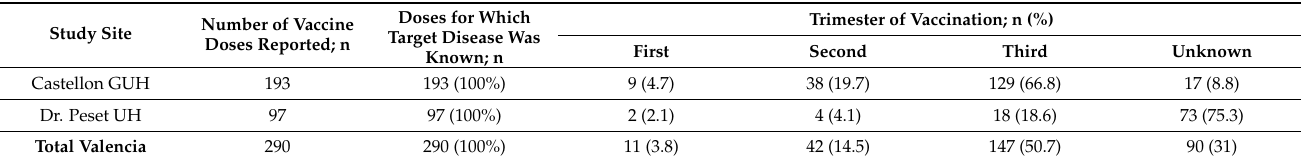
Table 5. Description of maternal immunization of all recruited cases: total number of vaccine doses reported, number of doses for which target disease was known, and the trimester of vaccination.